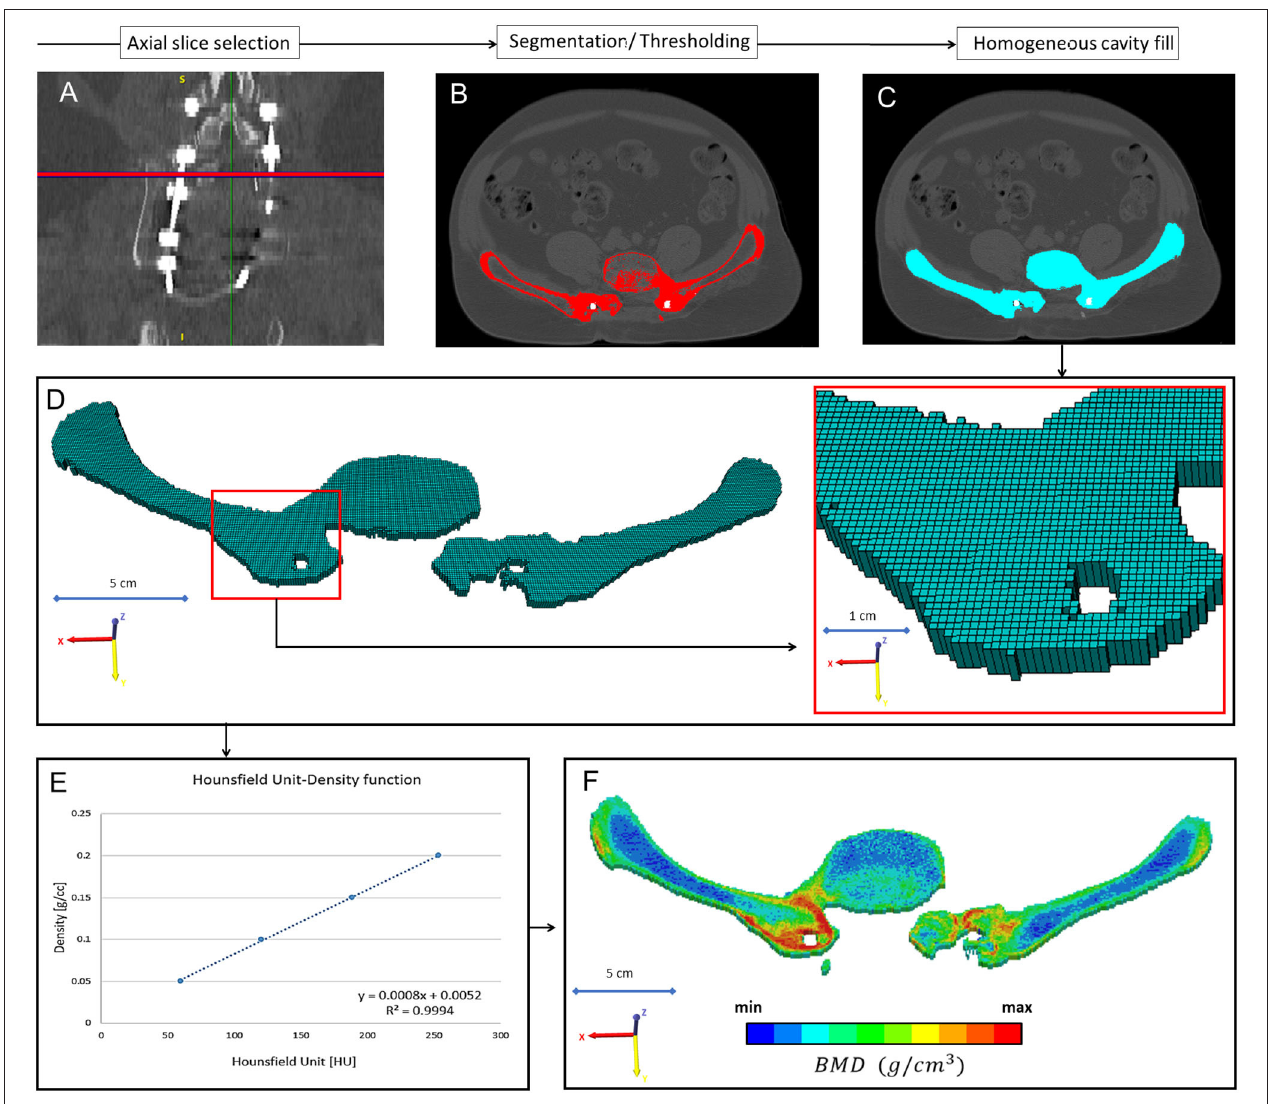
FIGURE 5 | Evaluation of the bony fusion process between the L5 vertebra and the two iliac bones. (A) From all the 12 CT scans the same region of interest (midplane between the right L4 and L5 pedicle screw) an axial slice was selected. (B) The bony elements were segmented in the selected slice. (C) A homogeneous mask was created corresponding to the segmented bony elements. (D) A voxel-based FE mesh was created based on the segmented mask. (E) A linear relationship was used to assign the bone mineral density values for the corresponding Hounsfield values. (F) In the voxel-based FE mesh, every voxel was coded with a color code corresponding to the